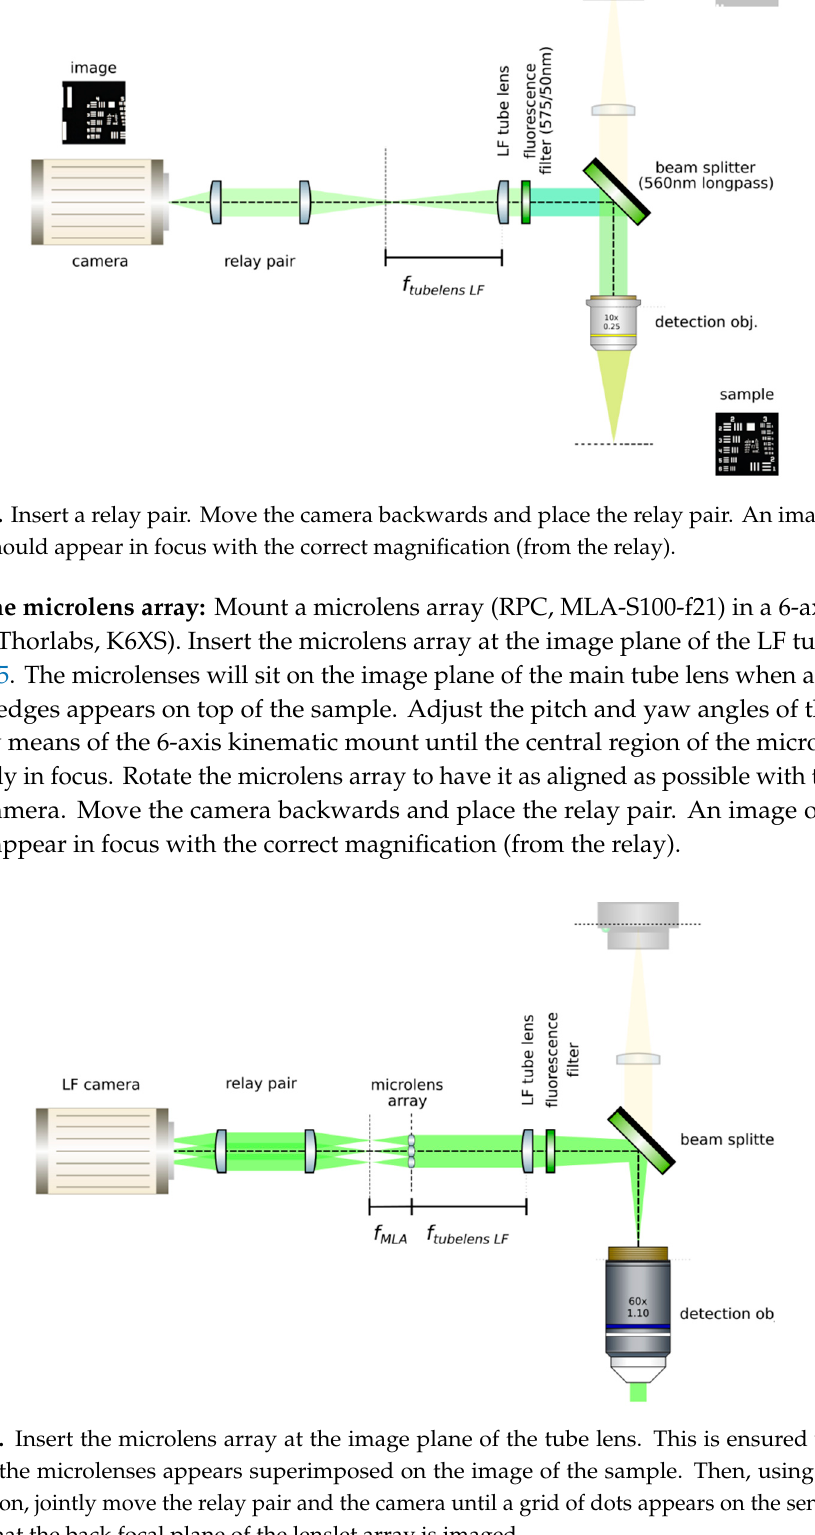
Figure 15. Insert the microlens array at the image plane of the tube lens. This is ensured when an image of the microlenses appears superimposed on the image of the sample. Then, using paraxial illumination, jointly move the relay pair and the camera until a grid of dots appears on the sensor. This ensures that the back focal plane of the lenslet array is imaged.